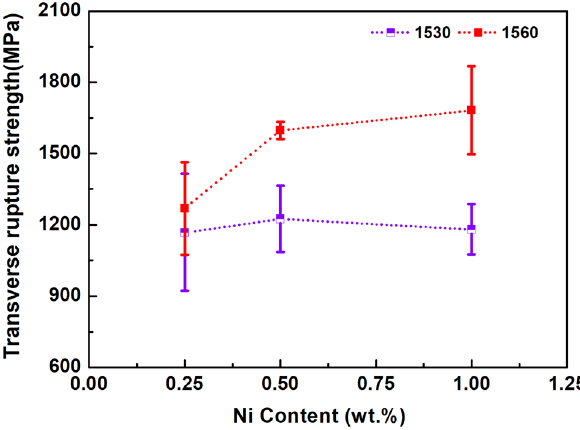
Figure 9: Flexural strength of each specimen of WC – Ni composite